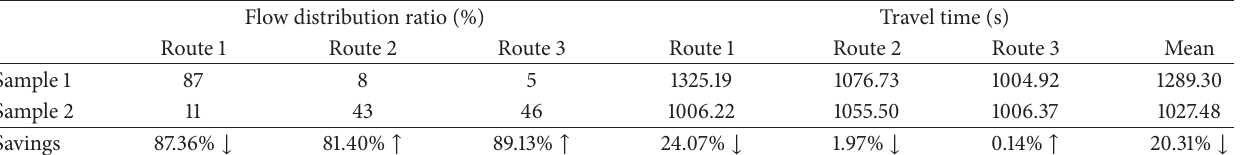
Table 2: Distribution of volume and average travel time for different routes.